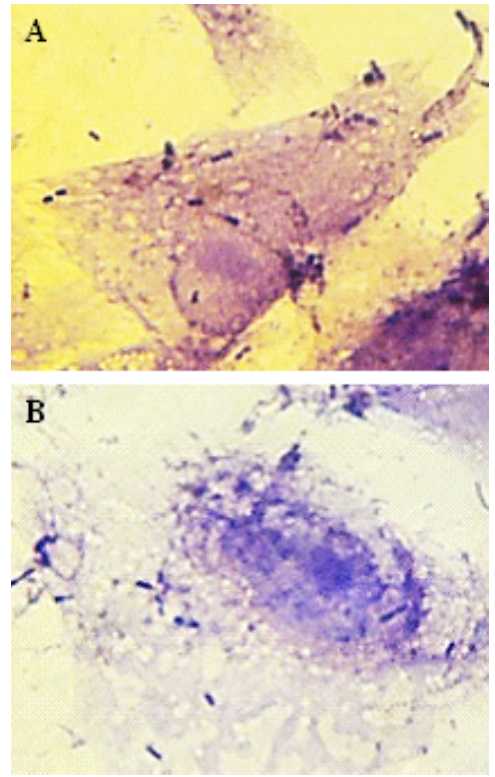
Figure 2: Gentamicin-HEp-2 cell invasion assay. Intracellular localization of S.sonnei(A) and S.flexneri(B) in HEp-2 cell monolayers after 3